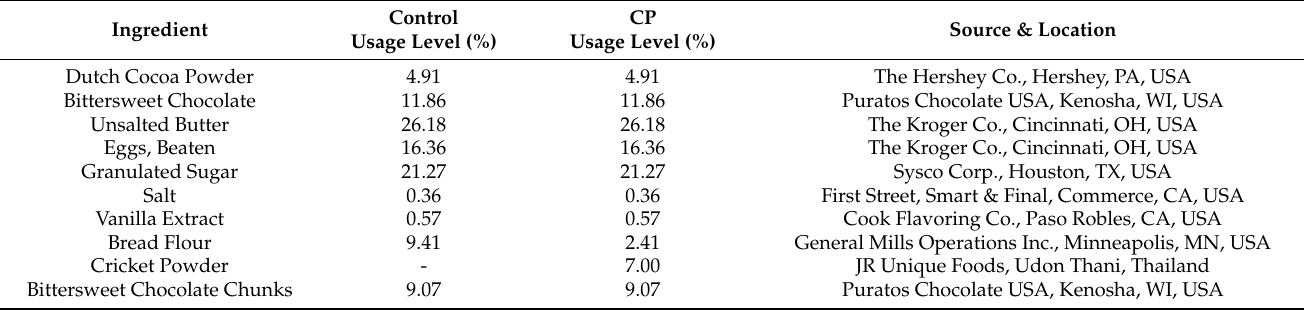
Table 3. The usage levels of the ingredients used for the brownies with NO cricket powder (Con- trol) and brownies containing cricket powder (CP). All percentages were rounded to the nearest hundredth